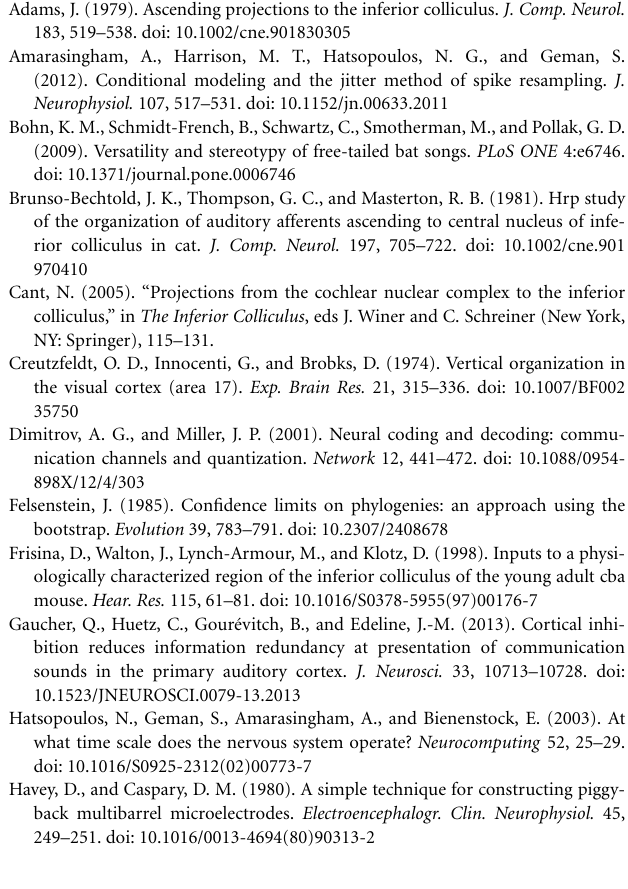
Supplementary Table 1 | Individual cell classification and statistics under control and inhibition blocked conditions. The reported statistics are: mean spike rate, mean response rate (spike rate to responsive stimuli), mutual information (MI) and MI per spike